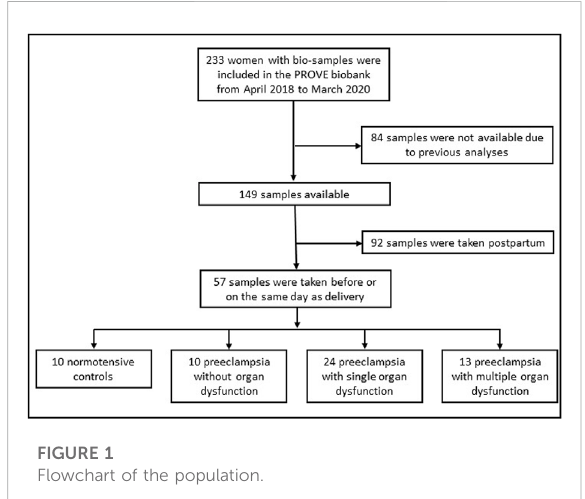
FIGURE 1 Flowchart of the